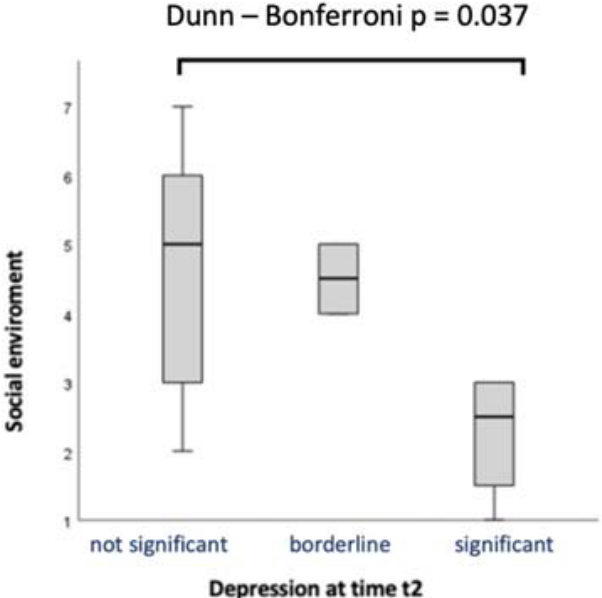
Figure 1. Social environment and